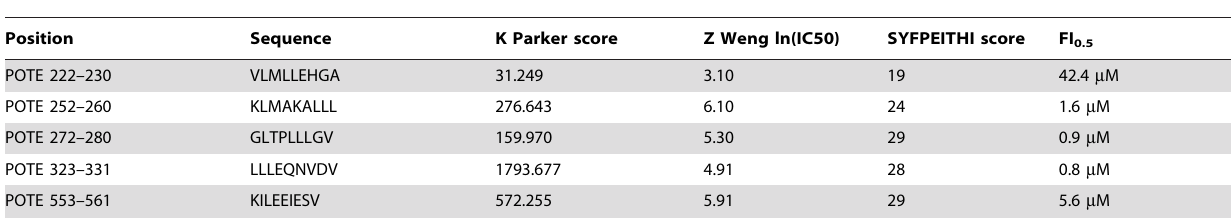
Table 1. List of predicted HLA-A2 binders of POTE protein.